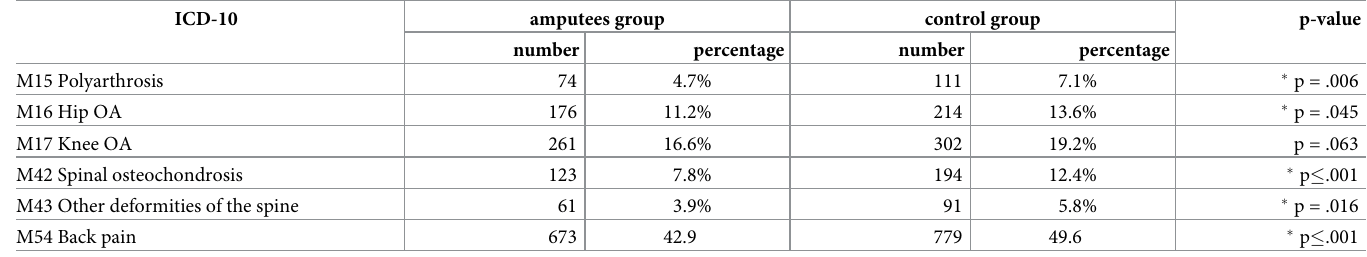
Table 1. Number of insured affected by the selected musculoskeletal disorders. Asterisks ( � ) denote values significantly different between the two groups (alpha = 0.05).